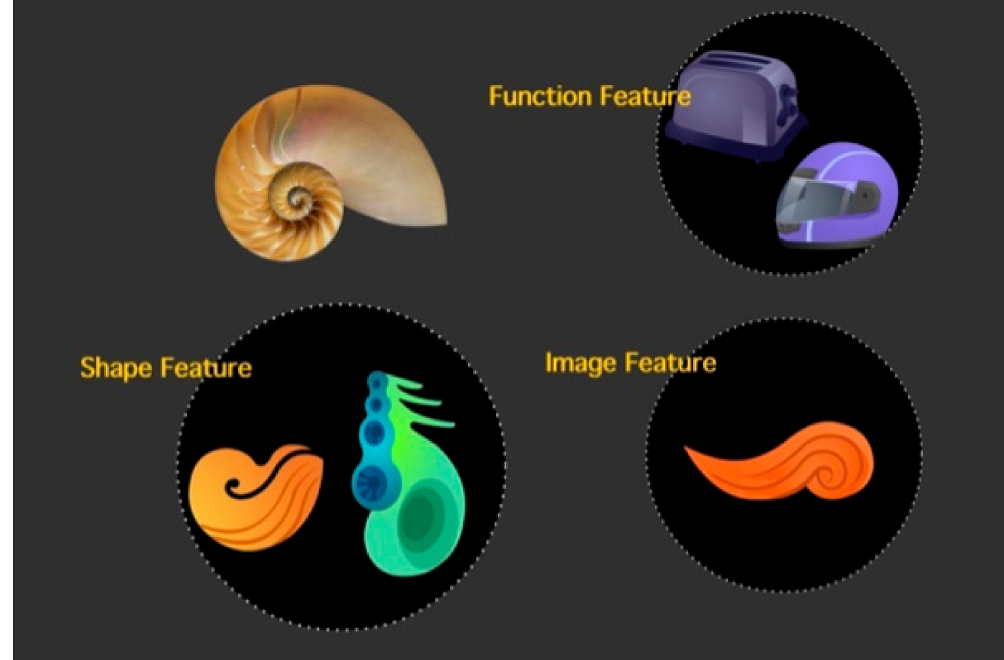
Figure 1. Levels of stylization for